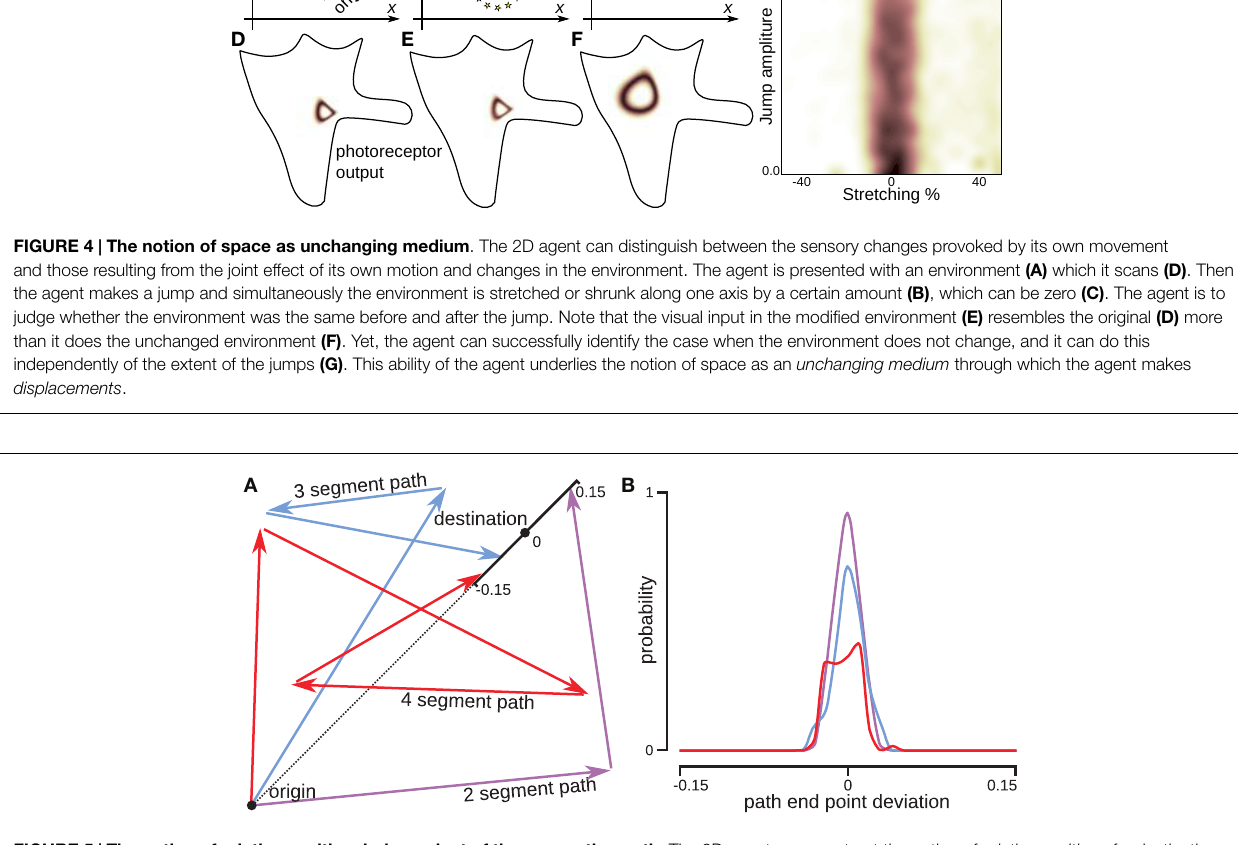
FIGURE 5 | The notion of relative position, independent of the connecting path . The 2D agent can construct the notion of relative position of a destination point with respect to an origin by associating all possible paths connecting the origin to the destination. The agent was presented with a reference single-segment path. Then it was returned to the origin and moved along two-, three-, or four-segment paths with possibly different destination points at a distance in the range [ − 0.15, 0.15] from the destination of the reference path; all points were chosen on the same straight line (A) . The surrounding environment was altered at every path presentation in order to ensure that the agent calculated the displacement instead of comparing the view at the destination points. The agent successfully associated together paths which arrived close to the original destination point. This association was more accurate for the 2-segment path, and became weaker as the number of path segments increased (B) . This can be explained by accumulation of the integration